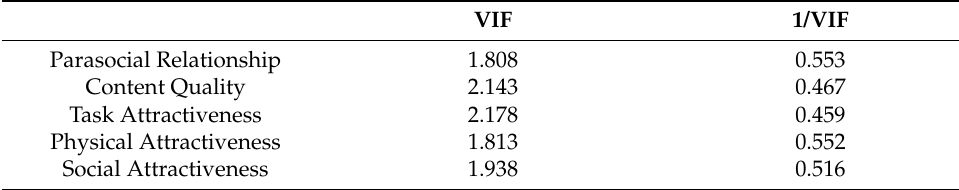
Table 4. Variance inflation factor (VIF)